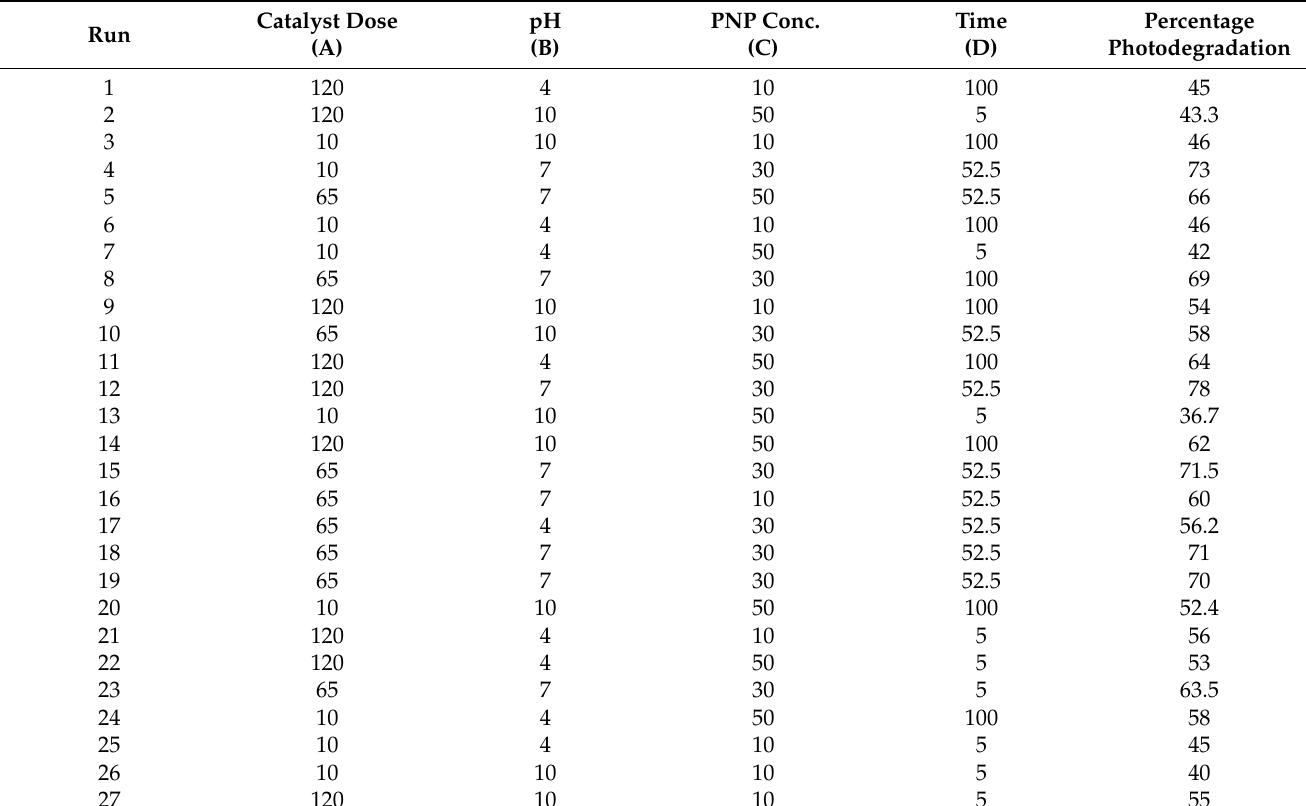
Table 3. Experimental runs for the prediction of optimum parameters for PNP degradation using central composite